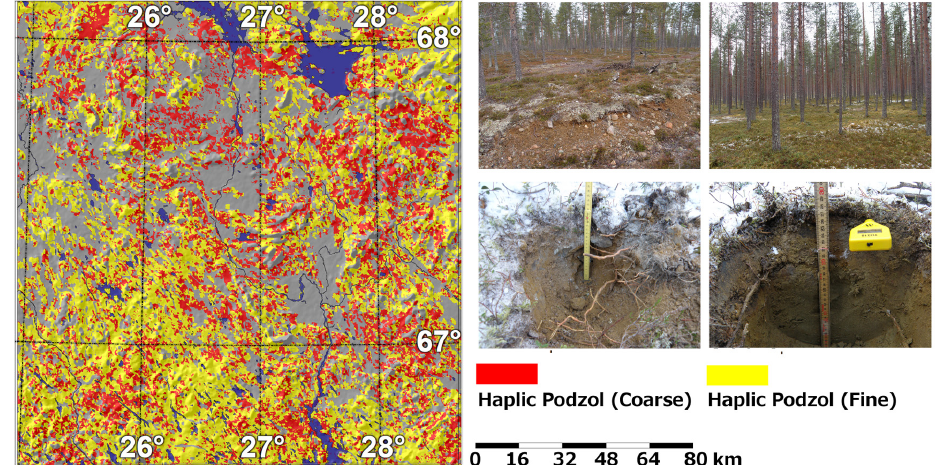
Figure 3. Distribution of Haplic Podzols within the Sodankylä region (left panel) and typical top soil profiles and vegetation (right panels).